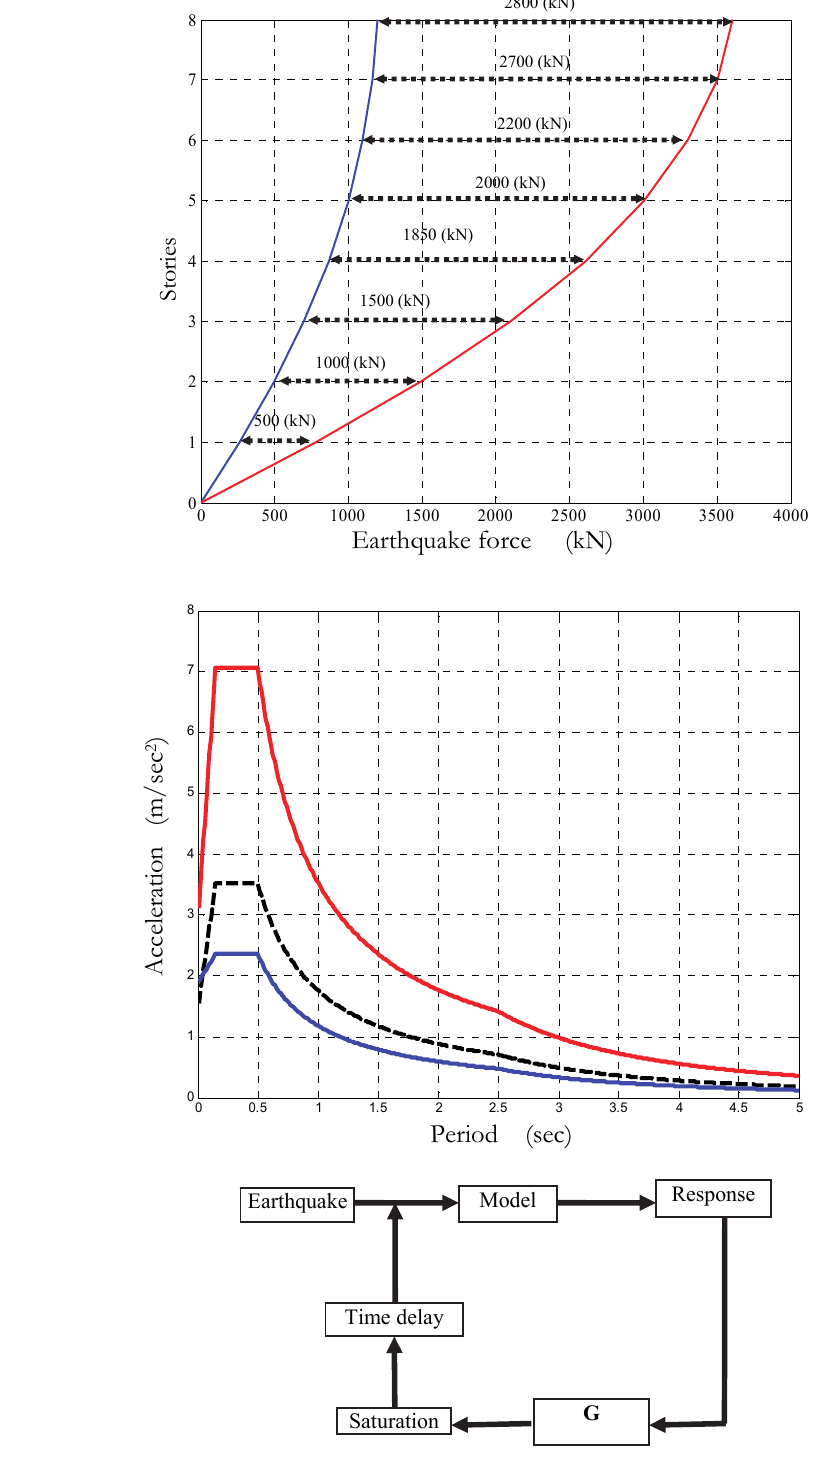
Figure 3 : The difference between elastic and design forces for each story, (a), the elastic and design spectrum, (solid lines), and the reduced elastic spectrum (dash line) for the structure with control devices, (b). Model and control scheme in Simuling toolbox